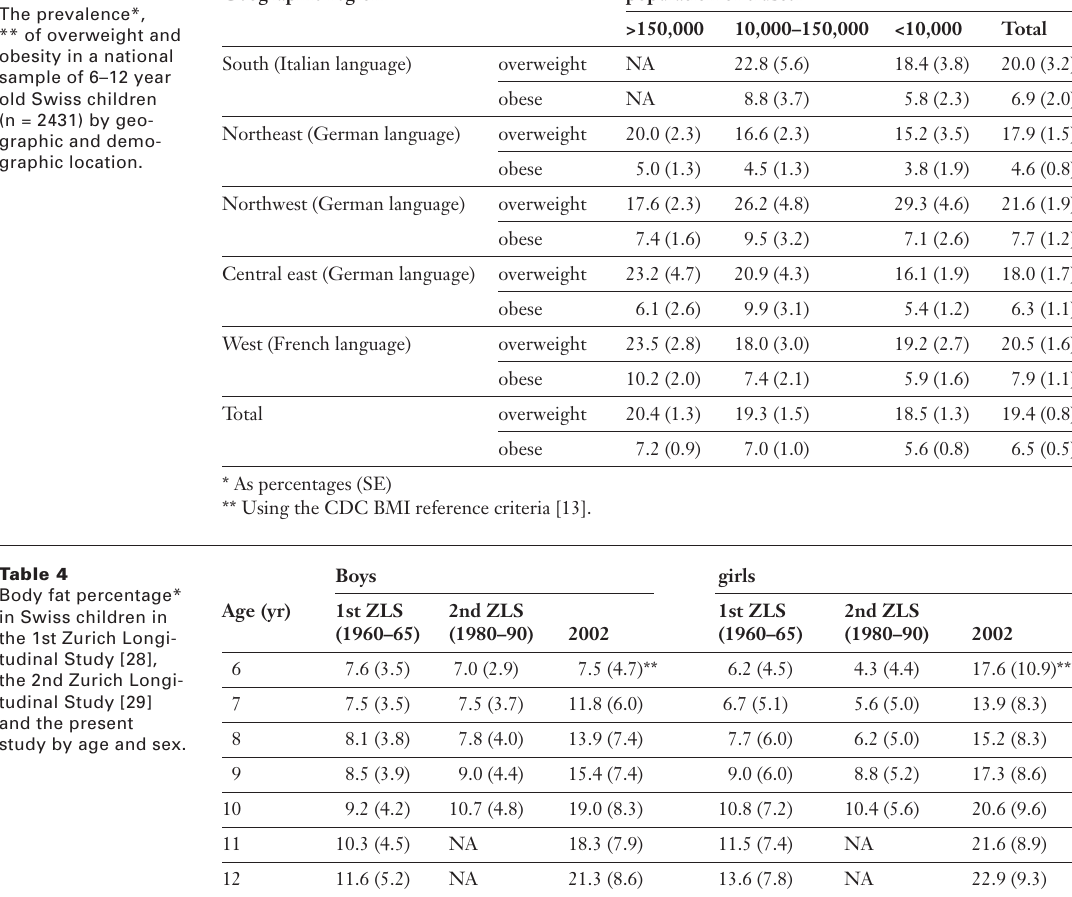
Table 3 The prevalence*, ** of overweight and obesity in a national sample of 6–12 year old Swiss children (n = 2431) by geo- graphic and demo- graphic location.